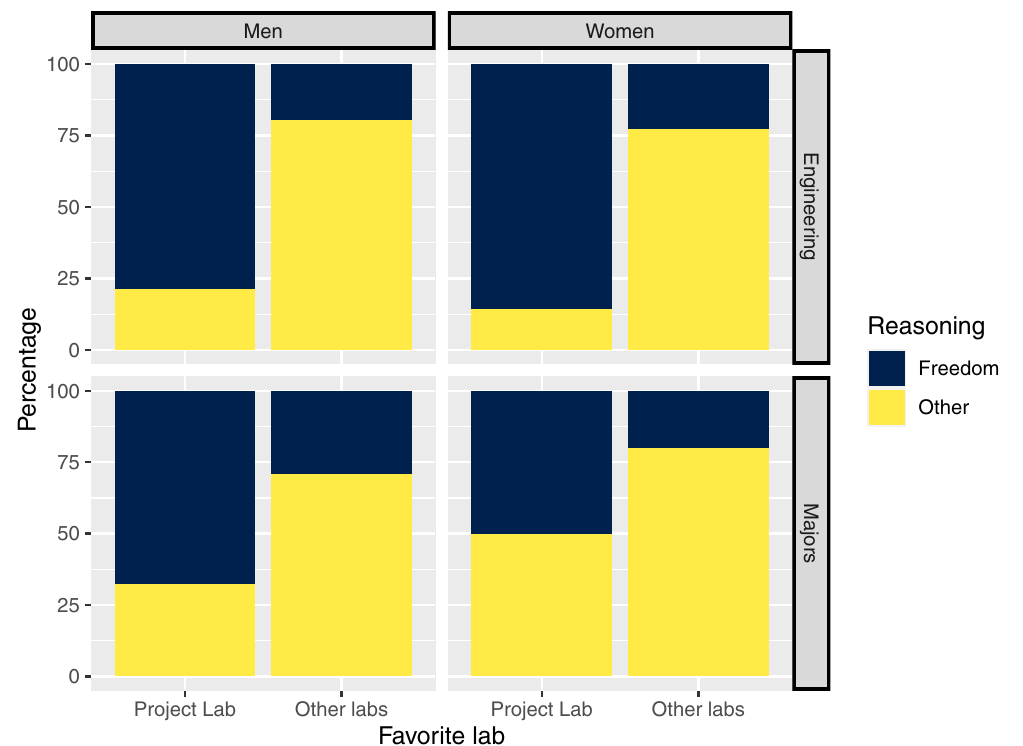
FIG. 3. Physics and engineering students ’ reasoning to their preferred lab unit as a percentage across gender, course, and favorite lab. For example, the first bar in the top left quadrant indicates, of the women in the engineering course who preferred project lab, the percentage of their explanations that were coded as freedom versus the